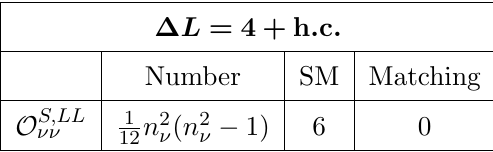
Table 18 . Dimension-six ∆ L = 4 operators in LEFT. There are also Hermitian conjugate operators, as indicated in the table heading. The second column is the number of operators for an arbitrary number of neutrino flavors n ν , and the third column is the number in the SM LEFT with n ν = 3. The last column is the tree-level matching coefficient in SMEFT.